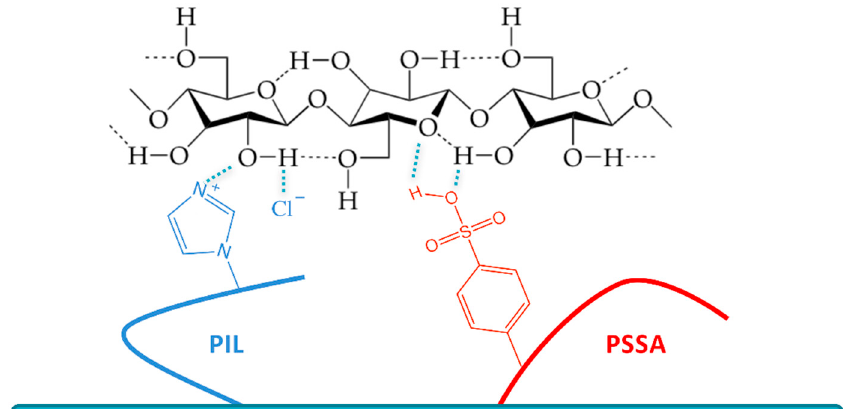
Figure 1. The proposed interaction between PSSA, PIL and cellulose chains in the hydrolysis. Intramolecular hydrogen bonds in the cellulose chain are the black dashed line. Hydrogen bonds formed between PIL/PSSA and cellulose chains are the green dashed line.